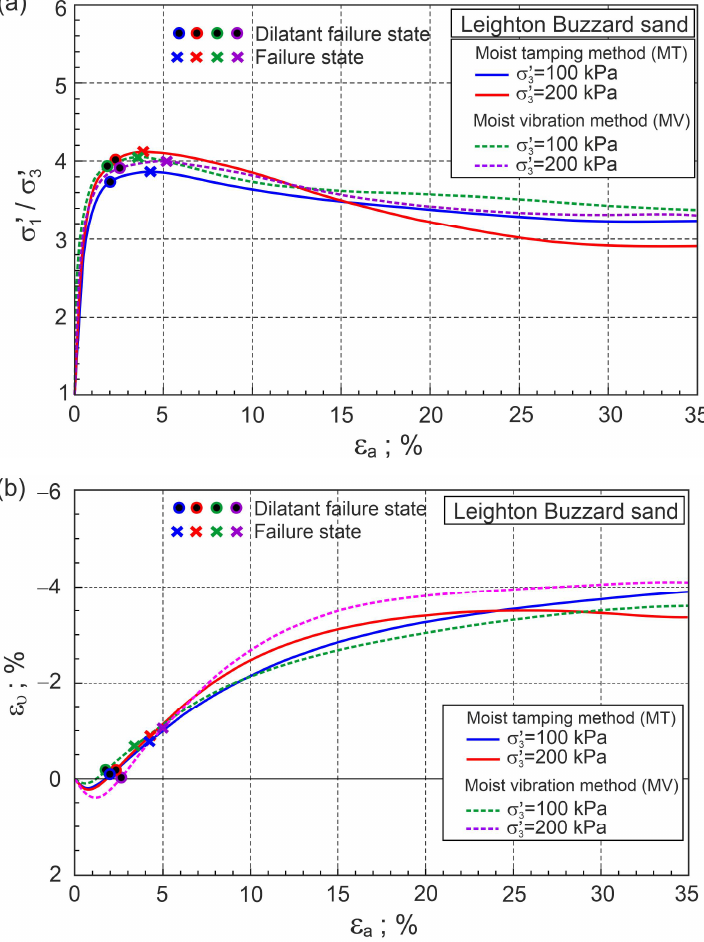
Figure 9. Relationships for pure Leighton Buzzard sand: ( a ) (cid:2026) (cid:2869)(cid:4593) (cid:2026) (cid:2871)(cid:4593) ⁄ − (cid:2013) (cid:3028) and ( b ) (cid:2013) (cid:3100) − (cid:2013) (cid:3028) (experi- mental data from [34]).